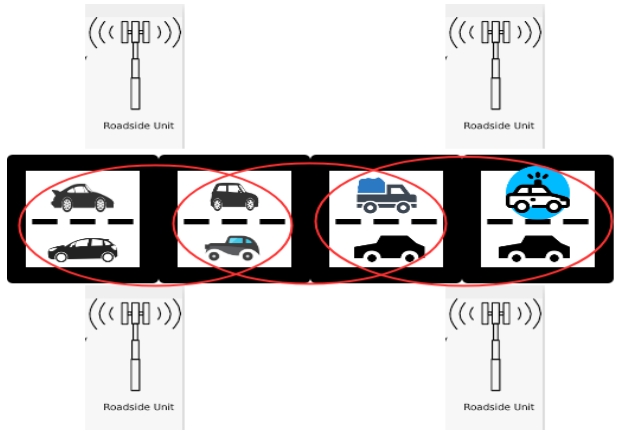
Figure 1. Architecture of vehicular adhoc network (VANET).